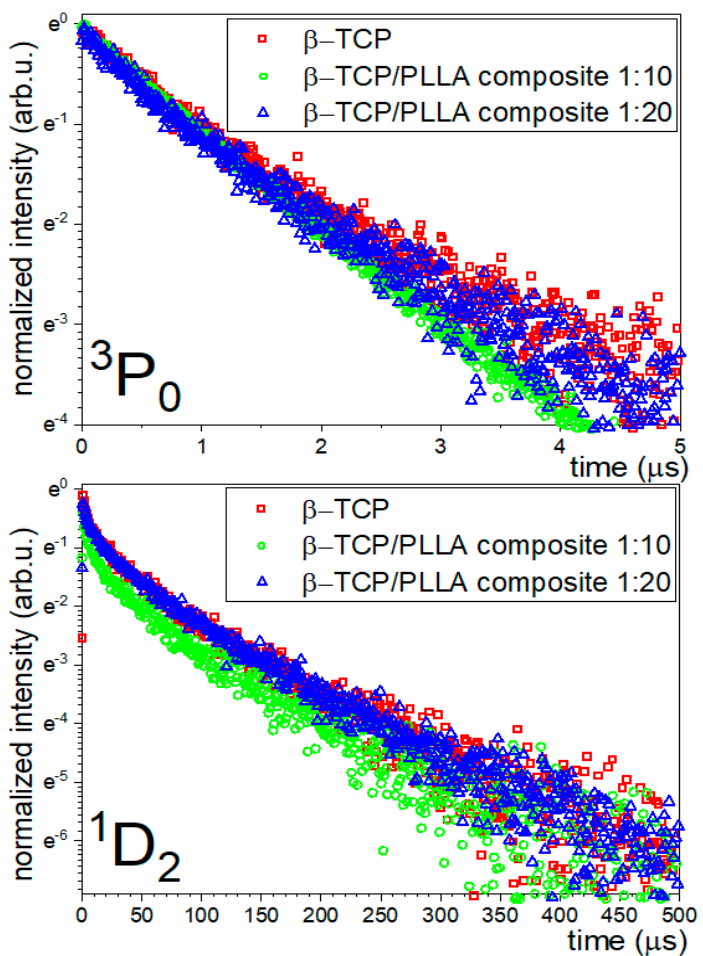
Figure 6. Luminescence kinetics curves of β -TCP co-doped with Ce 3 + and Pr 3 + ions PLLA with β -TCP composite with phosphate: polymer 1:10 ratio and PLLA with β -TCP composite with phosphate: polymer 1:20 ratio, recorded at 650 nm ( 3 P 0 ) and recorded at 605 nm ( 1 D 2 ).